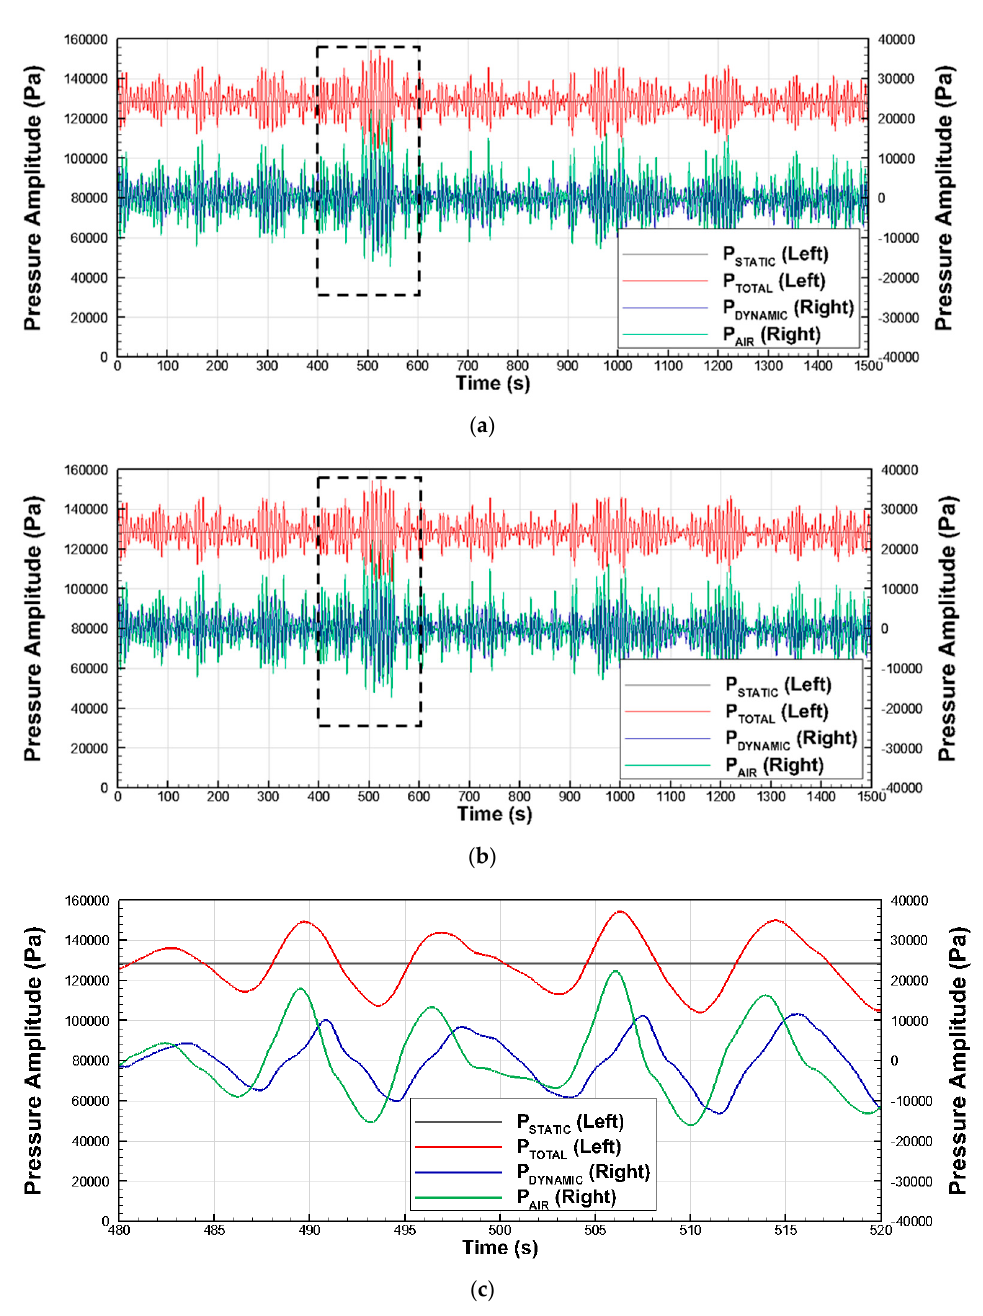
Figure 4. Pressure data obtained from the Yongsoo OWC pilot plant. ( a ) Time window = 0–1500 s; ( b ) Time window = 400–600 s; ( c ) Time window = 480–520 s.